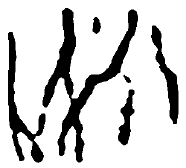
Figure 5. The segmented binary image.